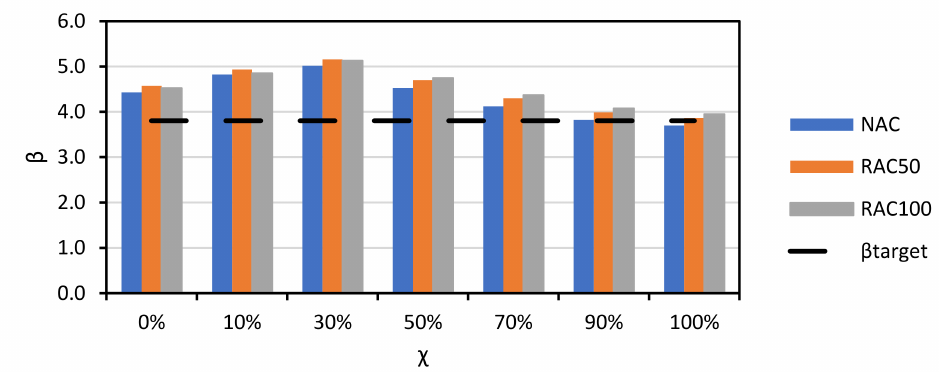
Figure 3. β vs. χ of Slab 1 for NAC and RAC. prEN1992 [32]. γ RAC of Table 2 (not calibrated).